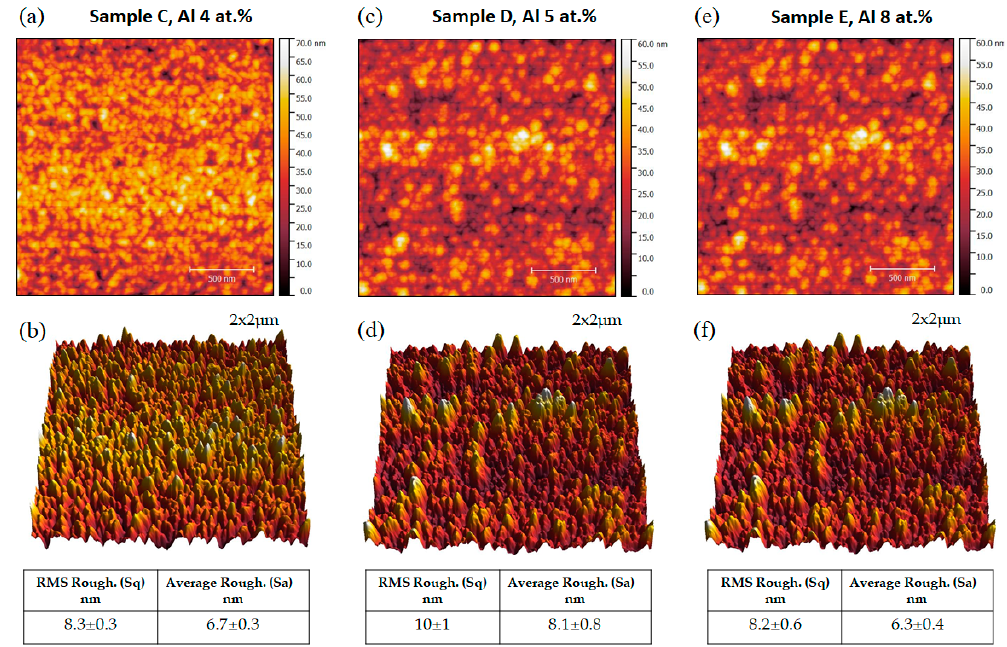
Figure 3. 2D (panels ( a ), ( c ), ( e )) and 3D (panels ( b ), ( d ), ( f )) AFM images, RMS, and average rough- ness of the AZO thin fi lm with 4 at.%, 5 at.%, and 8 at.% l (samples C, D, and